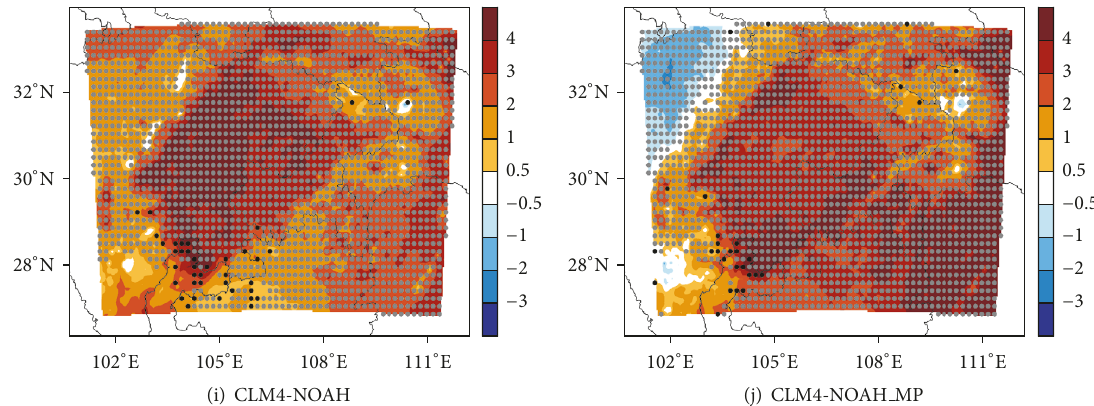
Figure 4: Mean SAT06 differences from 10 experiments (unit: ∘ C) and the results of Student’s 𝑡 -test for August 10 as simulated by different LSSs (gray and gray plus black dots denote grid points at significance levels of 5% and 10%, resp.).